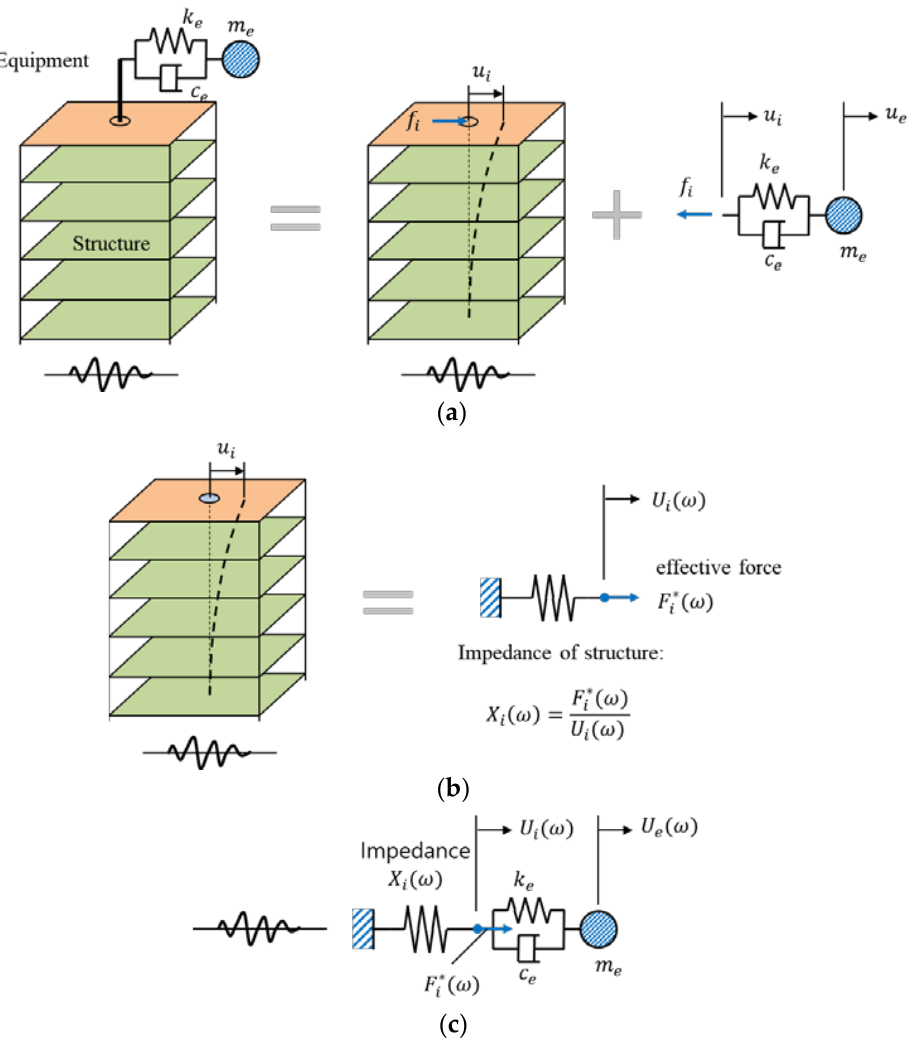
Figure 2. Coupled model considering equipment–structure interaction: ( a ) Coupled system with full DOFs; ( b ) Decoupled system and corresponding mechanical impedance function; ( c ) Condensed coupled system.